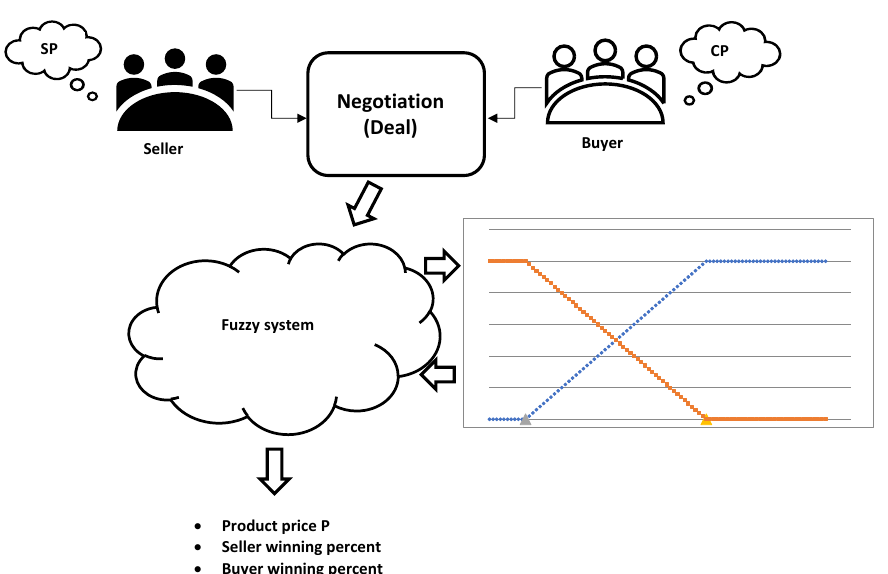
Figure 3. Schematic diagram of the fuzzy win–win